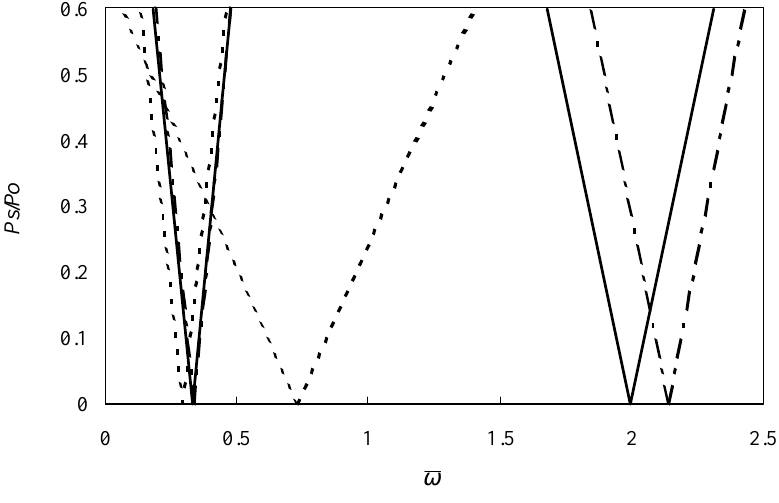
Fig. 8. First two instability regions for a rotating beam with double cracks at x cmean = 0 . 5 L , Ω = 1 and L = 1 . 0 m. ‘-.-.-’ a/h = 0 . 25 , ‘– ’ a/h = 0 . 50 , ‘- - -’ a/h = 0 . 75